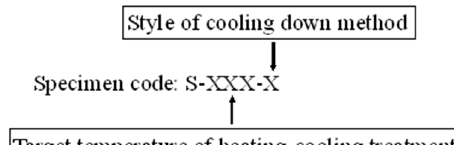
Figure 10. Specimen code.